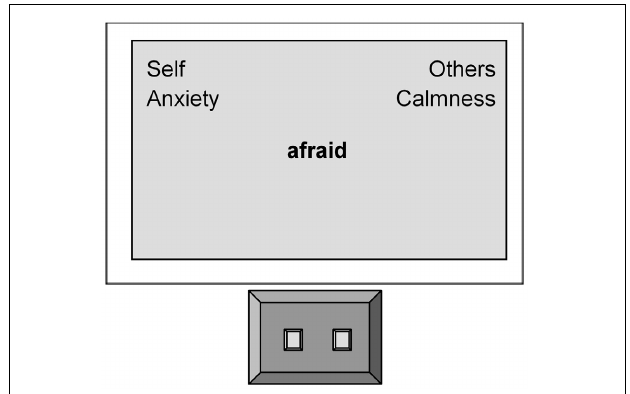
FIGURE 1 | Illustration of the Implicit Association Test with the target categories “Self” and “Others” and the attribute categories “Anxiety” and “Calmness” to which stimuli (e.g., afraid) must be categorized by using two response keys. Note that the position (left, right) of the attribute categories is changed within the